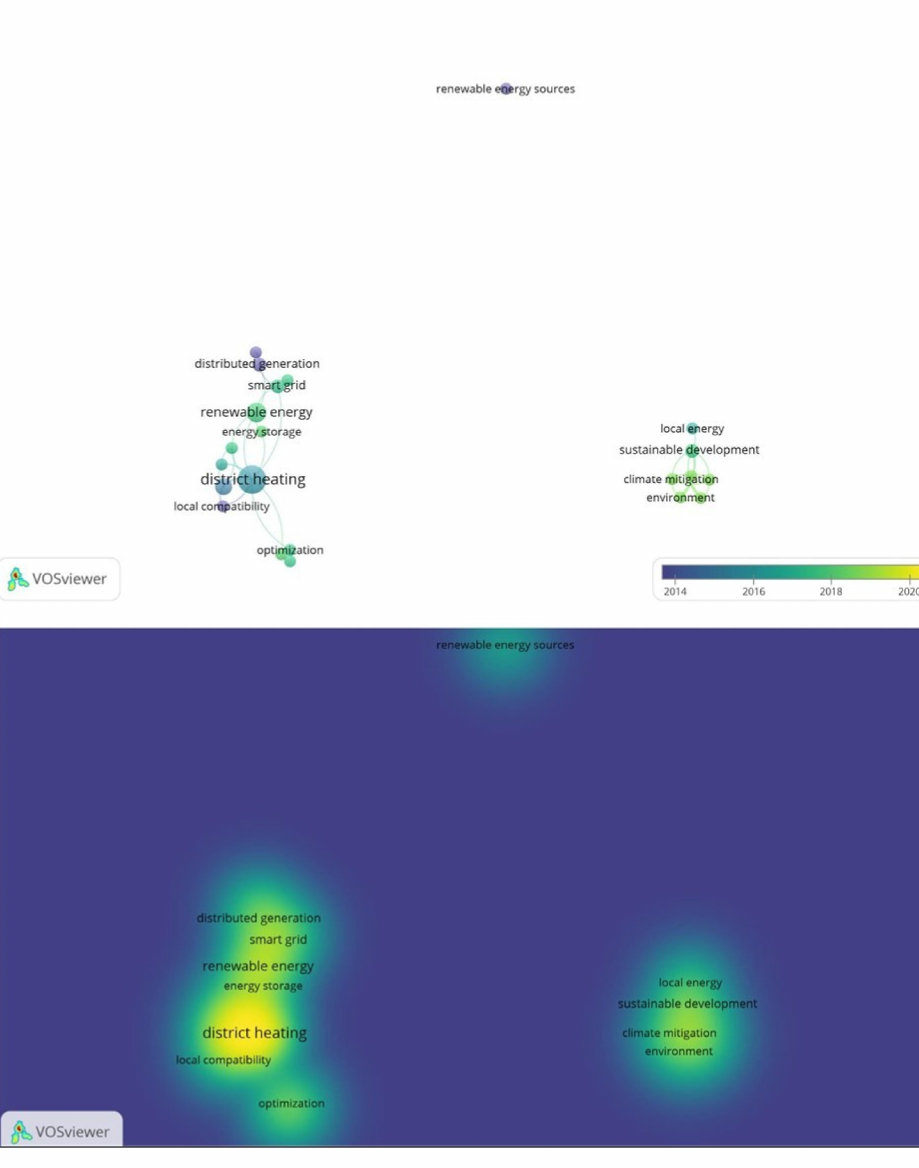
Figure 7. VVS output, overlay and density maps, visualizing the main keywords appearing in the bibliography in the context of thermal/cooling energy and local